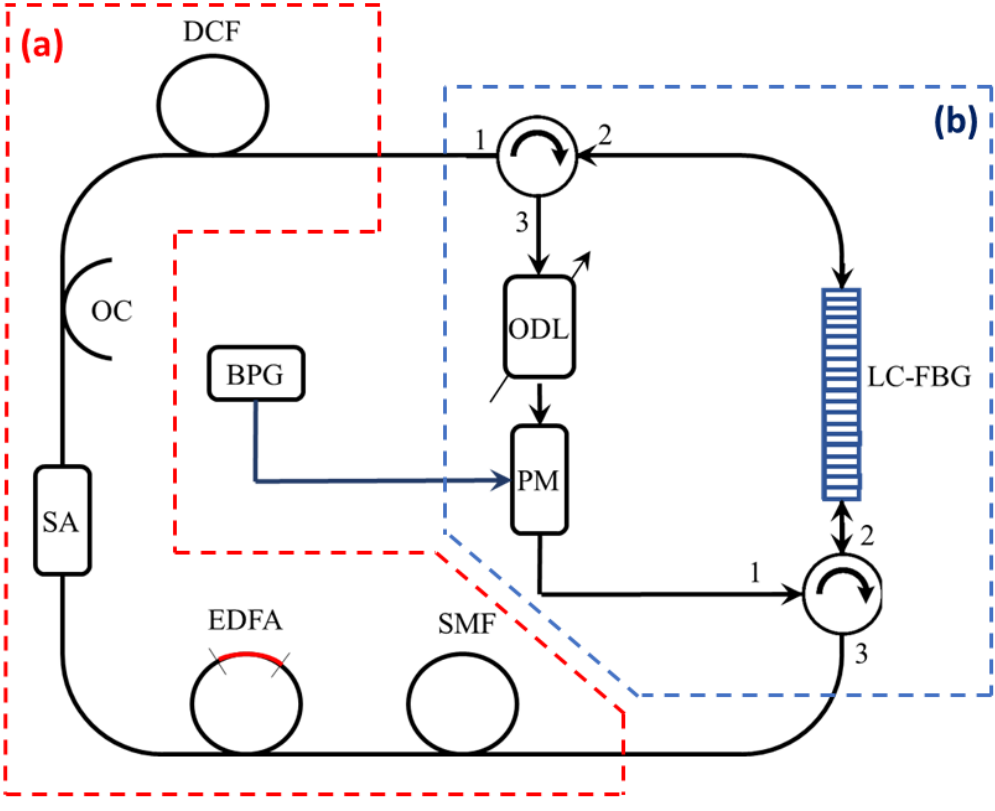
Figure 2. Proposed mode-locked laser design with intracavity pulse shaper: ( a ) Basic laser cavity. ( b ) Phase-only pulse shaper. DCF: dispersion compensating fiber; OC: output coupler; SA: saturable absorber; EDFA: erbium doped fiber; SMF: single mode fiber; BPG: bit pattern generator; ODL: optical delay line; PM: phase modulator; LC-FBG: linearly chirped fiber Bragg